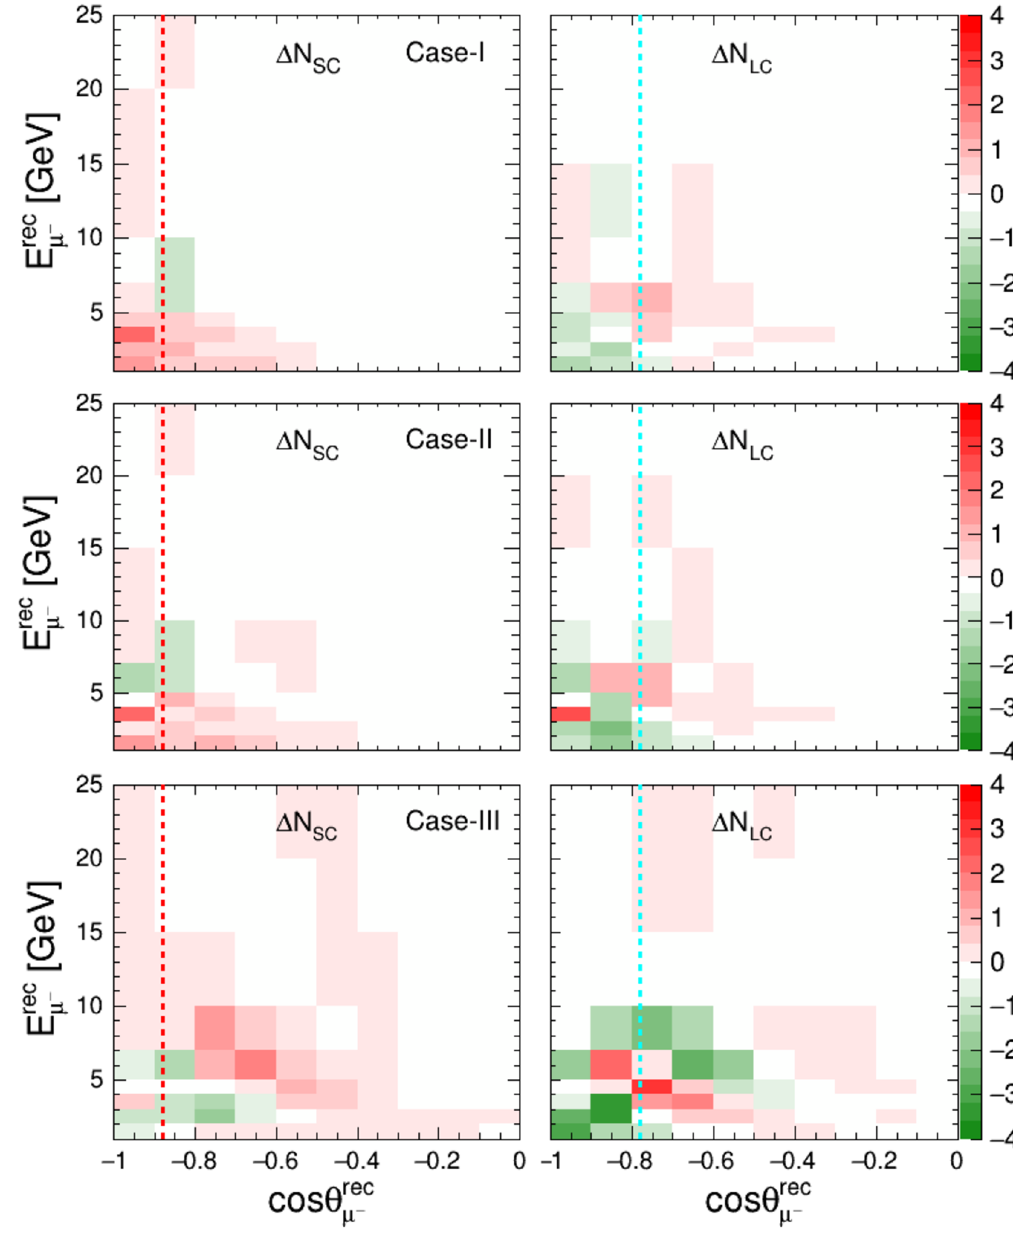
, cos θ rec ) distributions of the differences in reconstructed µ − events with the Figure 7 . The ( E rec µ − µ − standard and modified R . We have taken an exposure of 1 Mt · yr at the ICAL detector. In the CMB left (right) panels, ∆ N ( ∆ N ) denote the µ − event differences between the standard core and SC LC SC (LC) scenario with ∆ R = − 500 km ( +500 km). The dotted-red and dotted-cyan curves CMB represent the CMB radius for the smaller core and larger core, respectively. Top, middle, and bottom rows correspond to the Case-I, Case-II, and Case-III, respectively. We use the three-flavor neutrino oscillation parameters given in table 2, where we assume NO and sin 2 θ